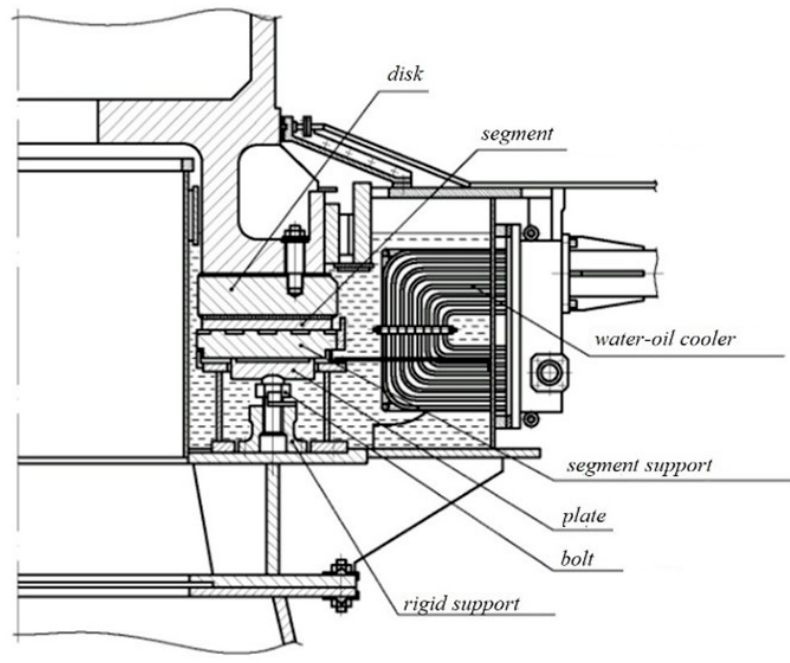
Figure 1. The design of the thrust bearing rest is on adjustable screw supports.